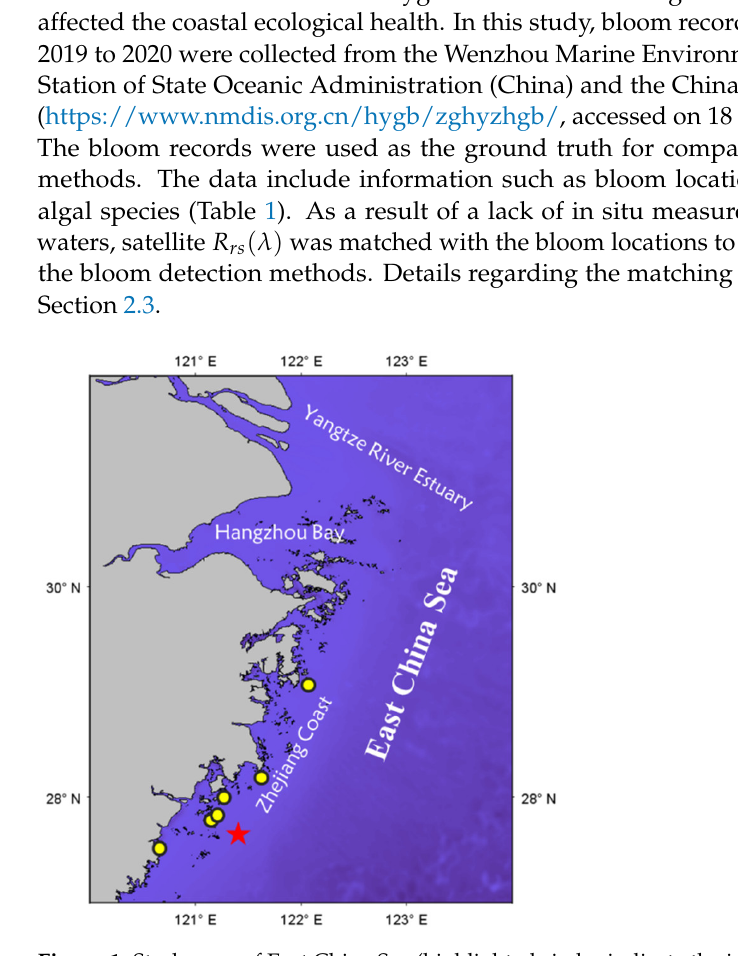
Figure 1. Study area of East China Sea (highlighted circles indicate the in situ observations of blooms; the red star shows the location of in situ R rs ( λ ) observation by Dongou Ocean Observing Platform). Table 1. East China Sea summer bloom events 2019–2021.